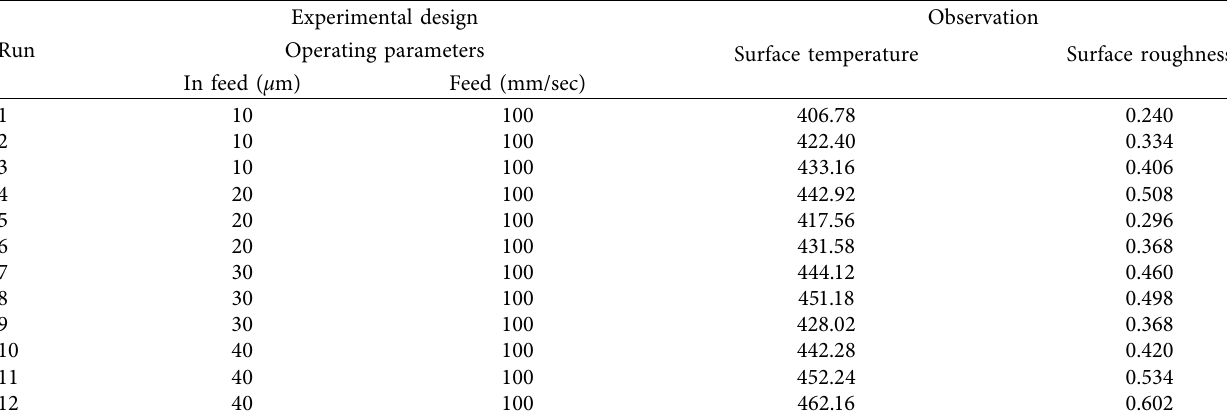
Table 6: Taguchi full factorial design: machining with conventional